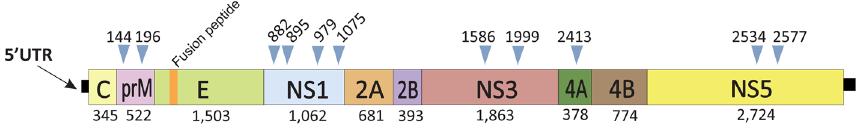
Figure 2. Genomic organization of GUAPV. The number under the box indicates the nucleotide length of each peptide and the blue triangle indicates the position of potential N-glycosylation sites.